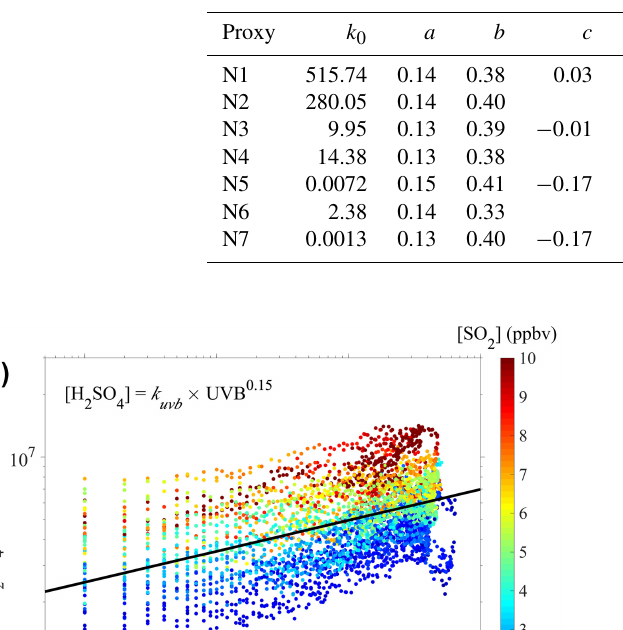
Table 4. Results of the nonlinear fitting procedure for different proxy functions, in addition to the correlation coefficient ( R , Pearson type) and the relative error (RE).